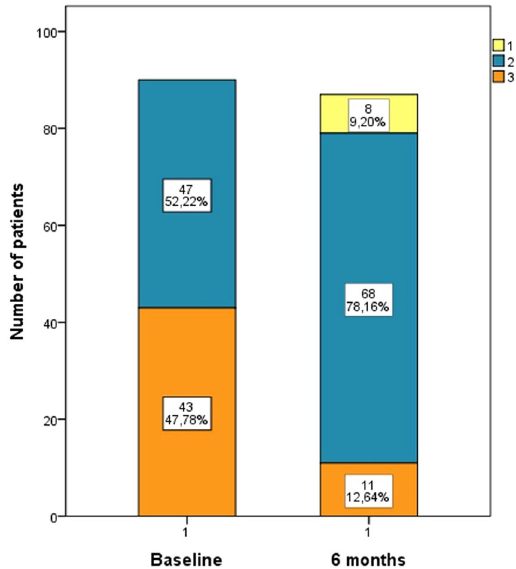
Figure 3. Bar graphs showing the changes of NYHA class from baseline to 6 months in patients treated with